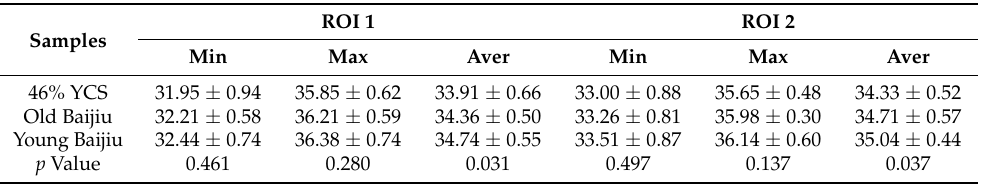
Table 4. Tongue surface temperatures after treated with the same ethanol content (46%, v/v ) of ethanol aqueous solution and Baijiu samples ( n =